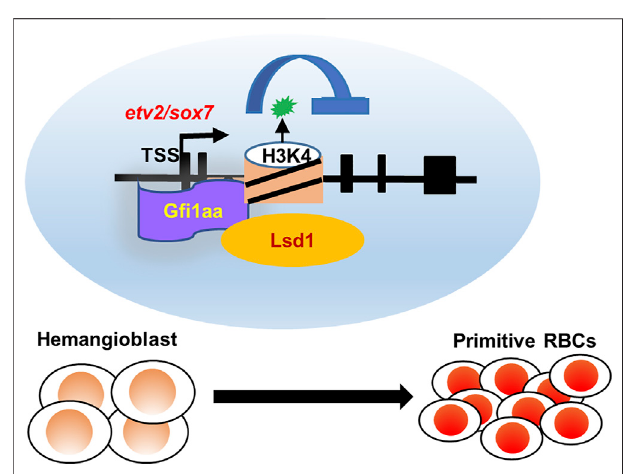
FIGURE 6 | Working model of G fi 1aa/Lsd1- etv2/sox7 in primitive erythropoiesis. G fi 1aa/Lsd1- etv2/sox7 regulatory modules in hemangioblast differentiation into primitive red blood